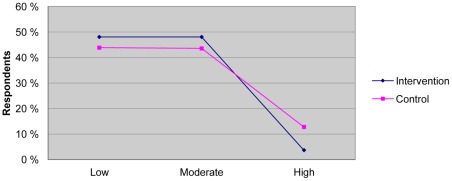
Rating of quality across study groups.